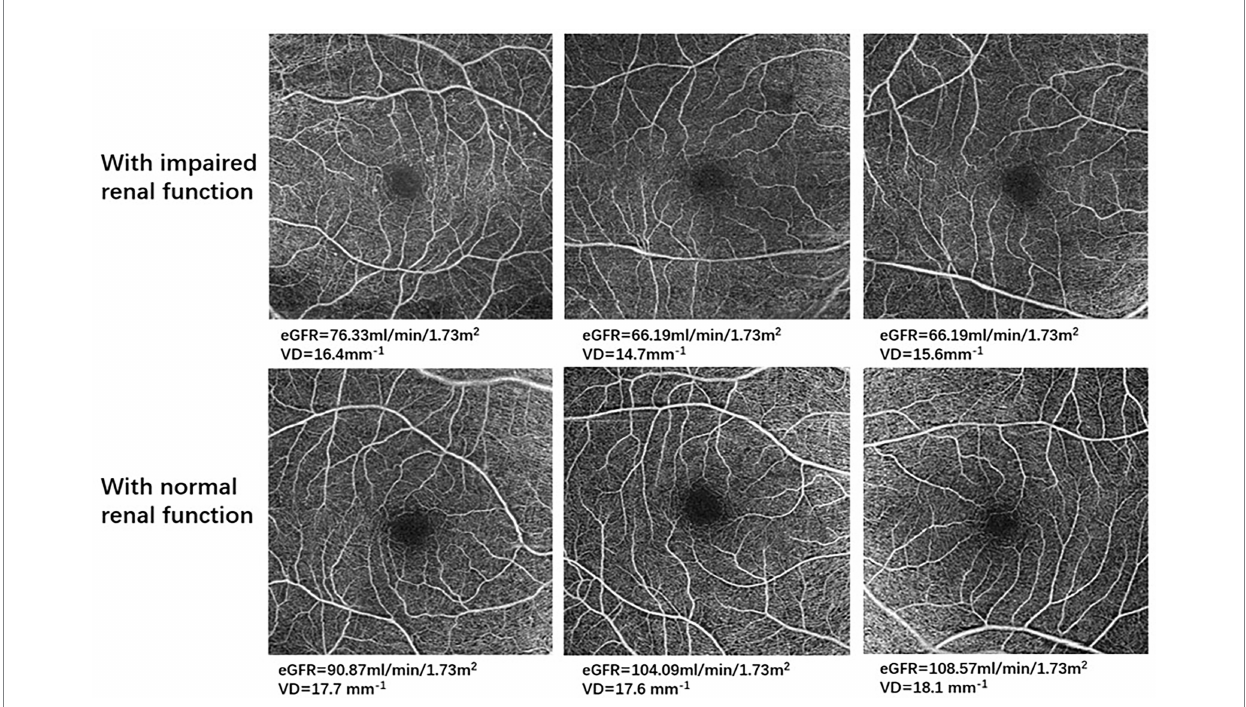
FIGURE 2 Optical coherence tomography angiography (OCTA) images in representative patients with impaired renal function and with normal renal function. For all 6 × 6-mm OCTA images, the top row demonstrates retinal microvasculature in type 2 diabetes mellitus (T2DM) patients with impaired renal function, and the bottom row shows retinal microvasculature in T2DM patients with normal renal